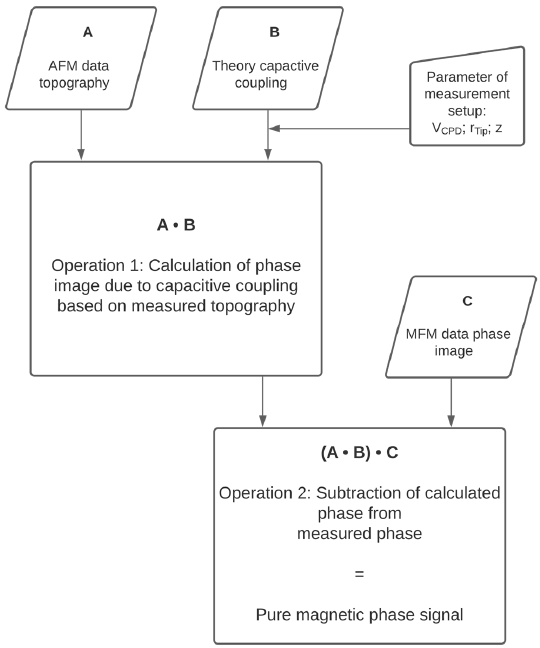
Figure 1. Workflow of data fusion procedure for the elimination of topographic crosstalk.